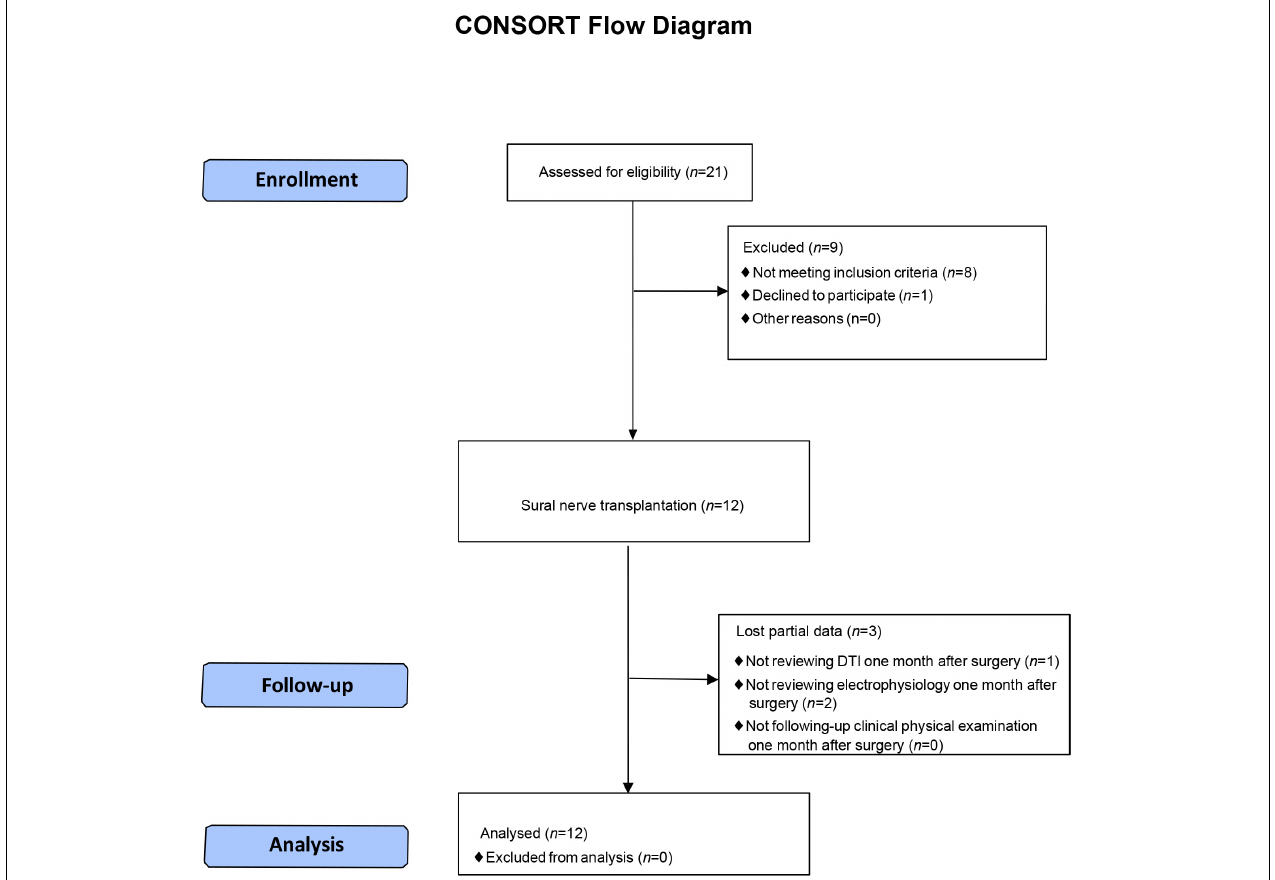
FIGURE 2 | CONSORT flow